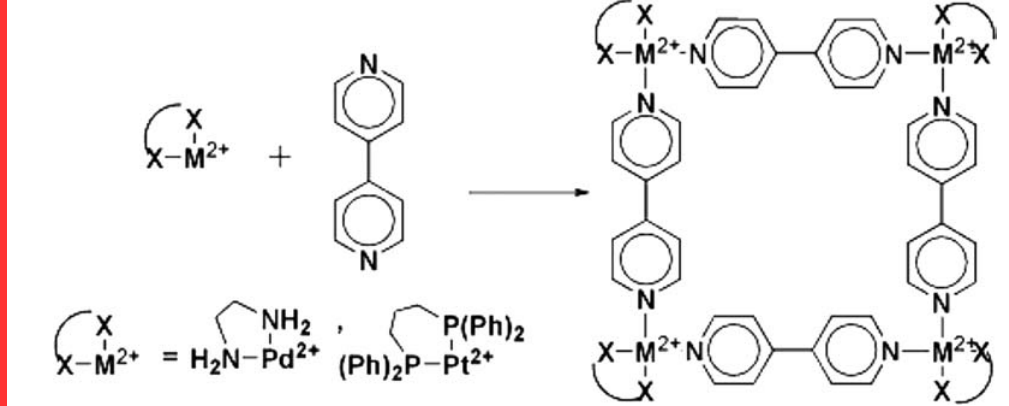
Figure 2. Syntheses of the self-assembled Pt(II) or Pd(II) macrocycles.